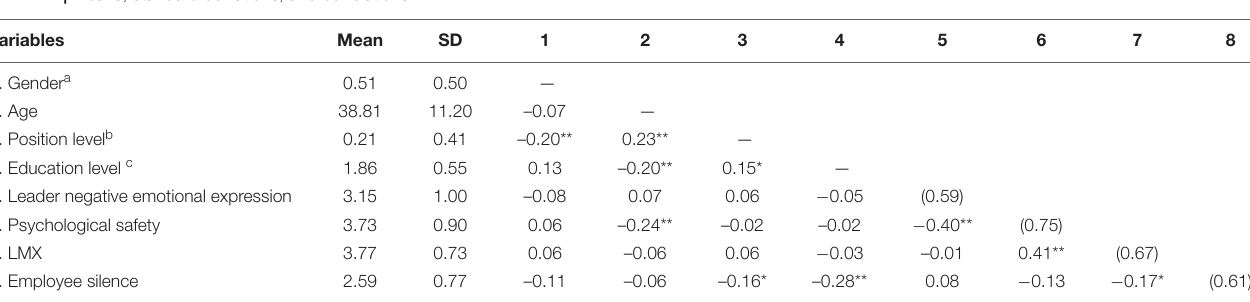
TABLE 1 | Means, standard deviations, and